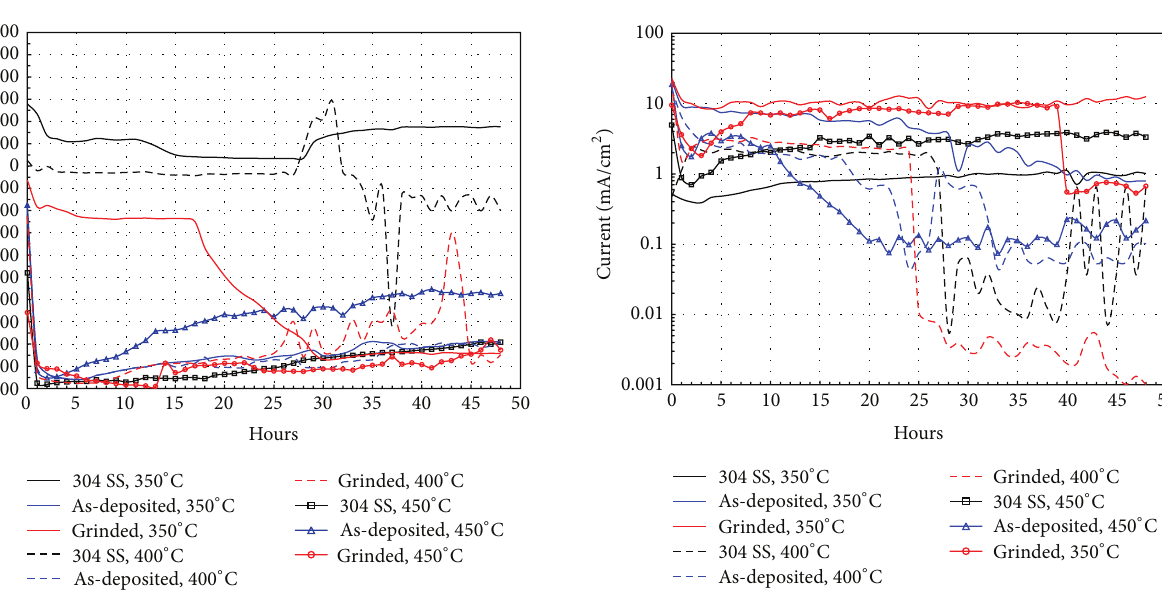
values as function of testing time for the corr